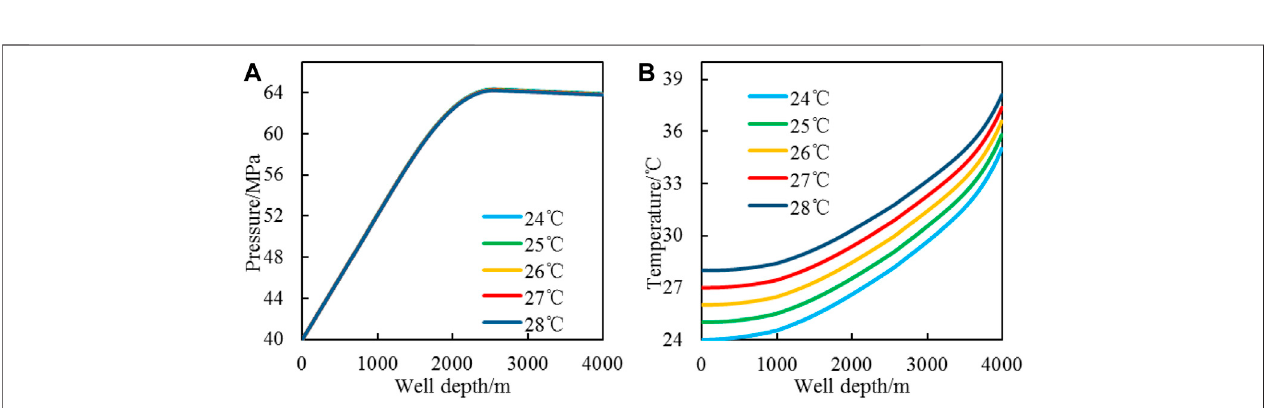
FIGURE 11 | CO 2 foam fracturing fl uid pressure and temperature change with injection temperature [ (A) : pressure pro fi le; (B) : temperature pro fi le].